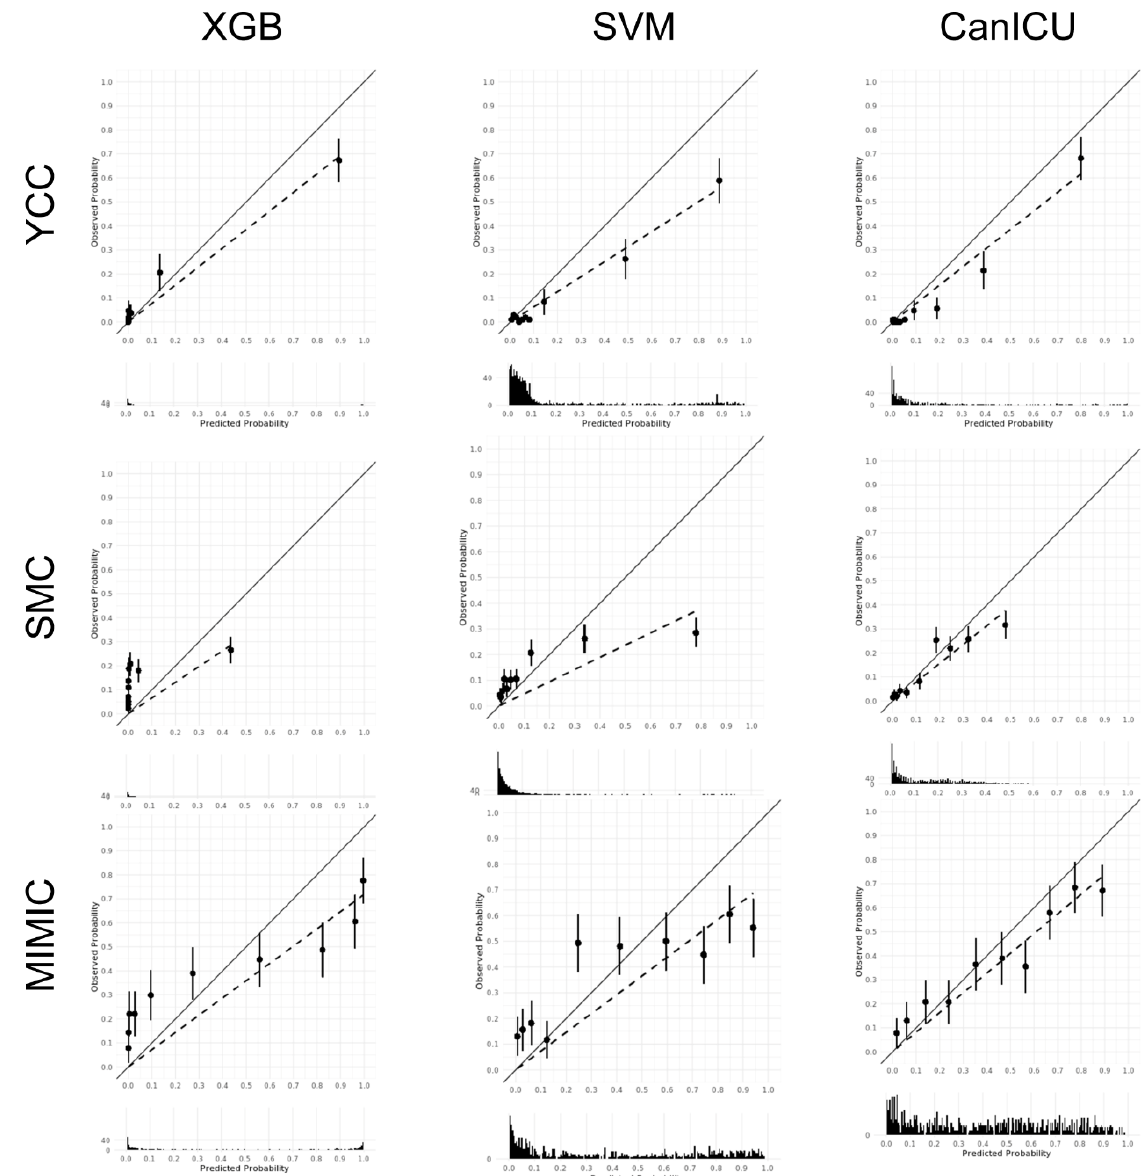
Figure 3. Calibration plots of the preliminary models and CanICU model for predicting 28-days mortality: XGB, xgboost; SVM, support vector machine; YCC, Yonsei Cancer Center; SMC, Samsung Medical Center; MIMIC, Medical Information Mart for Intensive Care.